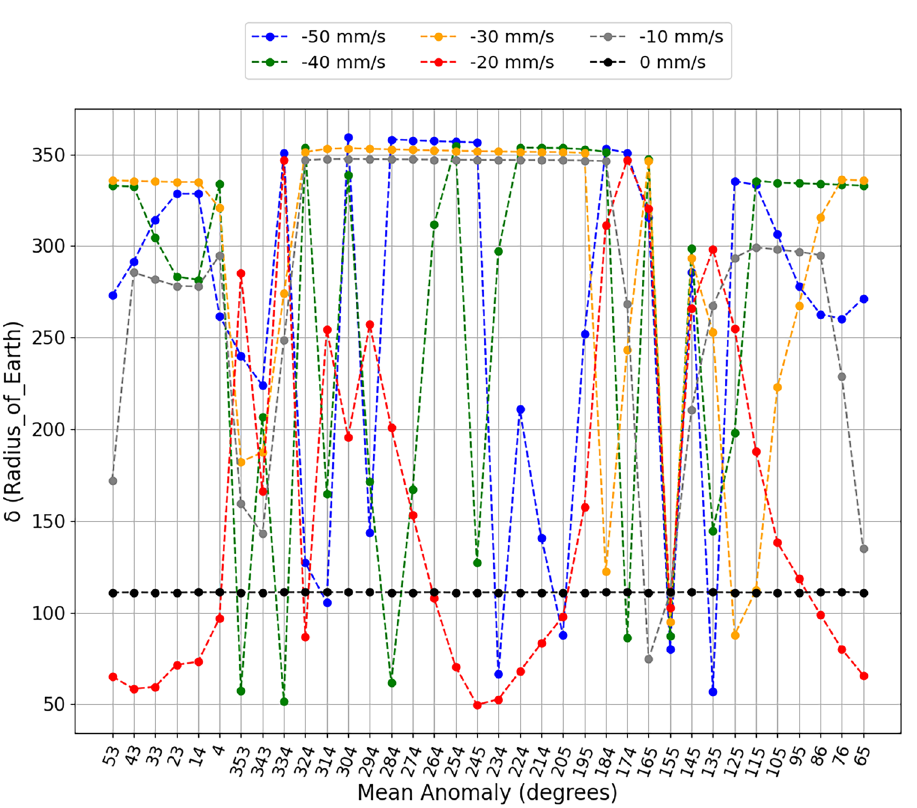
Figure 2. The closest approaches between the asteroid and the Earth along a period of about 100 years ( δ ) (y axis), after negative velocity variations at different mean anomalies (x axis) to simulate different positions for the application of impulse. The black dots are the closest approach of the asteroid to the Earth without the application of impulse. The δ is shown in terms of Earth